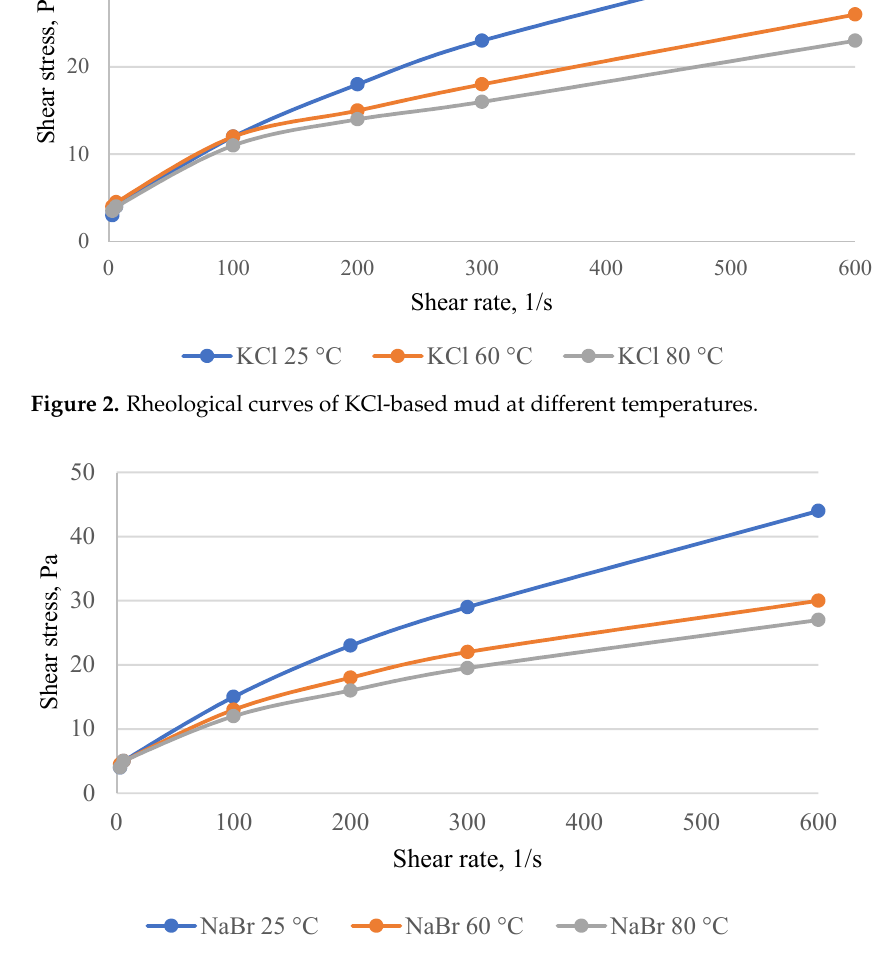
Figure 3. Rheological curves of NaBr-based mud at different temperatures.